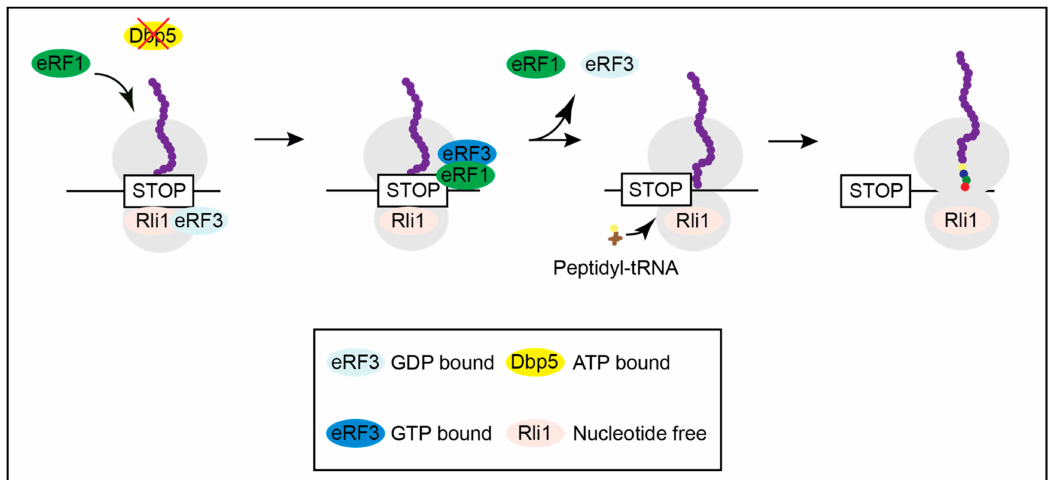
Figure 3. Lack of Dbp5 leads to translational readthrough. Mutations in Dbp5 prevent a shielded entry of eRF1 to the ribosome, resulting in an early contact of eRF1 and eRF3 and their subsequent dissociation. This increases the probability for the incorporation of a near-cognate tRNA and the continuation in